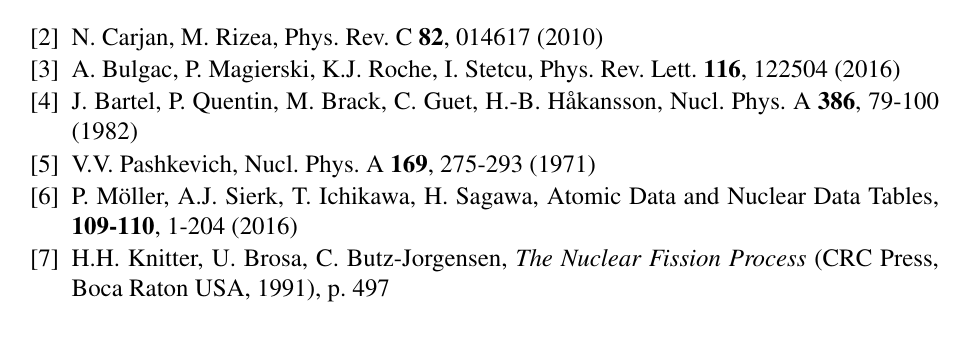
Figure 3. Evolution of β 2 and β 3 deformations of the nascent